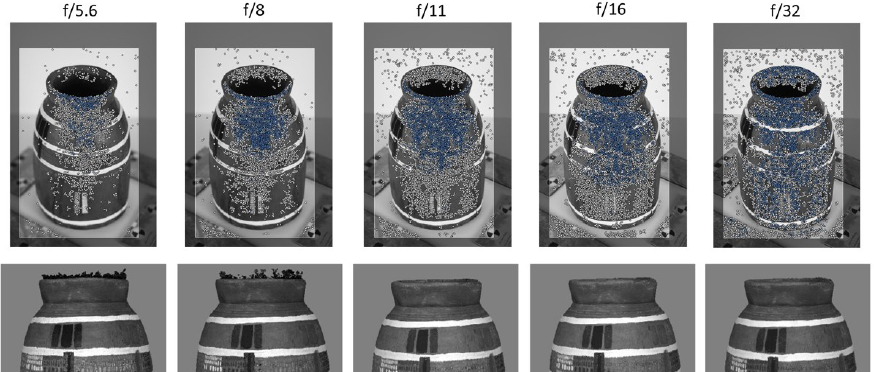
Figure 8. Top Row: PhotoScan matching points (i.e., tie points) results with blue points indicating used matches and correspond to points of the sparse point cloud and white points are unused matches. Bottom Row: Detailed views of resulting models with artefacts resulting from the smallest DOFs (f/5.6 and